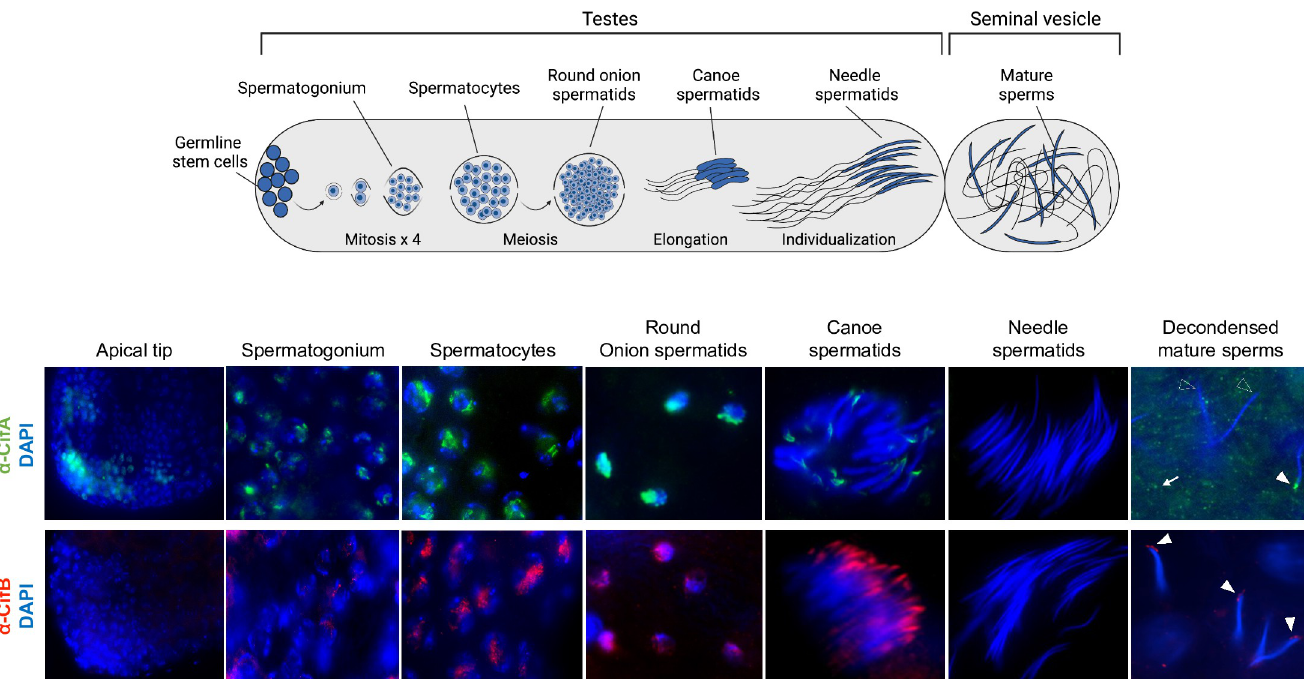
Fig 1. CifA and CifB invade sperm nuclei during spermatogenesis and spermiogenesis. Schematic representation of Drosophila melanogaster male reproductive system created with Biorender.com is shown on the top. Testes ( n = 20) from < 8-hour-old males expressing dual transgenes cifAB were dissected and immunostained to visualize CifA (green) and CifB (red) during sperm morphogenesis. DAPI stain (blue) was used to label nuclei. CifA, but not CifB, localizes in the germline stem cells at the apical end of testes. Both CifA and CifB localize in the nuclei of mitotic spermatogonium, spermatocytes, and round onion stage spermatids. In the later stages of spermiogenesis, elongating spermatids harbor CifA and CifB at the acrosomal tip of the heads. CifB is present in all canoe-stage spermatid nuclei, whereas CifA is present on average in 39% of spermatids per bundle. Cifs are not accessible by the antibodies in the tightly compacted spermatids at the needle stage. After decondensing mature sperms isolated from seminal vesicles (see Methods), CifA and CifB are detectable in the acrosome regions at varying percentages. CifA is common among sperm tails in a speckled pattern (white arrow) and either present on average in 45% or 0% of the mature sperm heads depending upon the sampled seminal vesicles. CifA’s presence in the acrosome region is shown by solid white arrowheads and absence with empty white arrowheads. CifB is present in acrosomal tips of all of the sperms (solid white arrowheads) and does not occur with sperm tails. CifA and CifB localization patterns are similar in wild-type ( w Mel+) line and signals are absent in Wolbachia -uninfected ( w Mel − )negative control line (S2 Fig). Some of the CifA and CifB proteins are also stripped by the individualization complex into the cytoplasmic waste bag (S5 Fig). The experiment was repeated in 2 biological replicates.